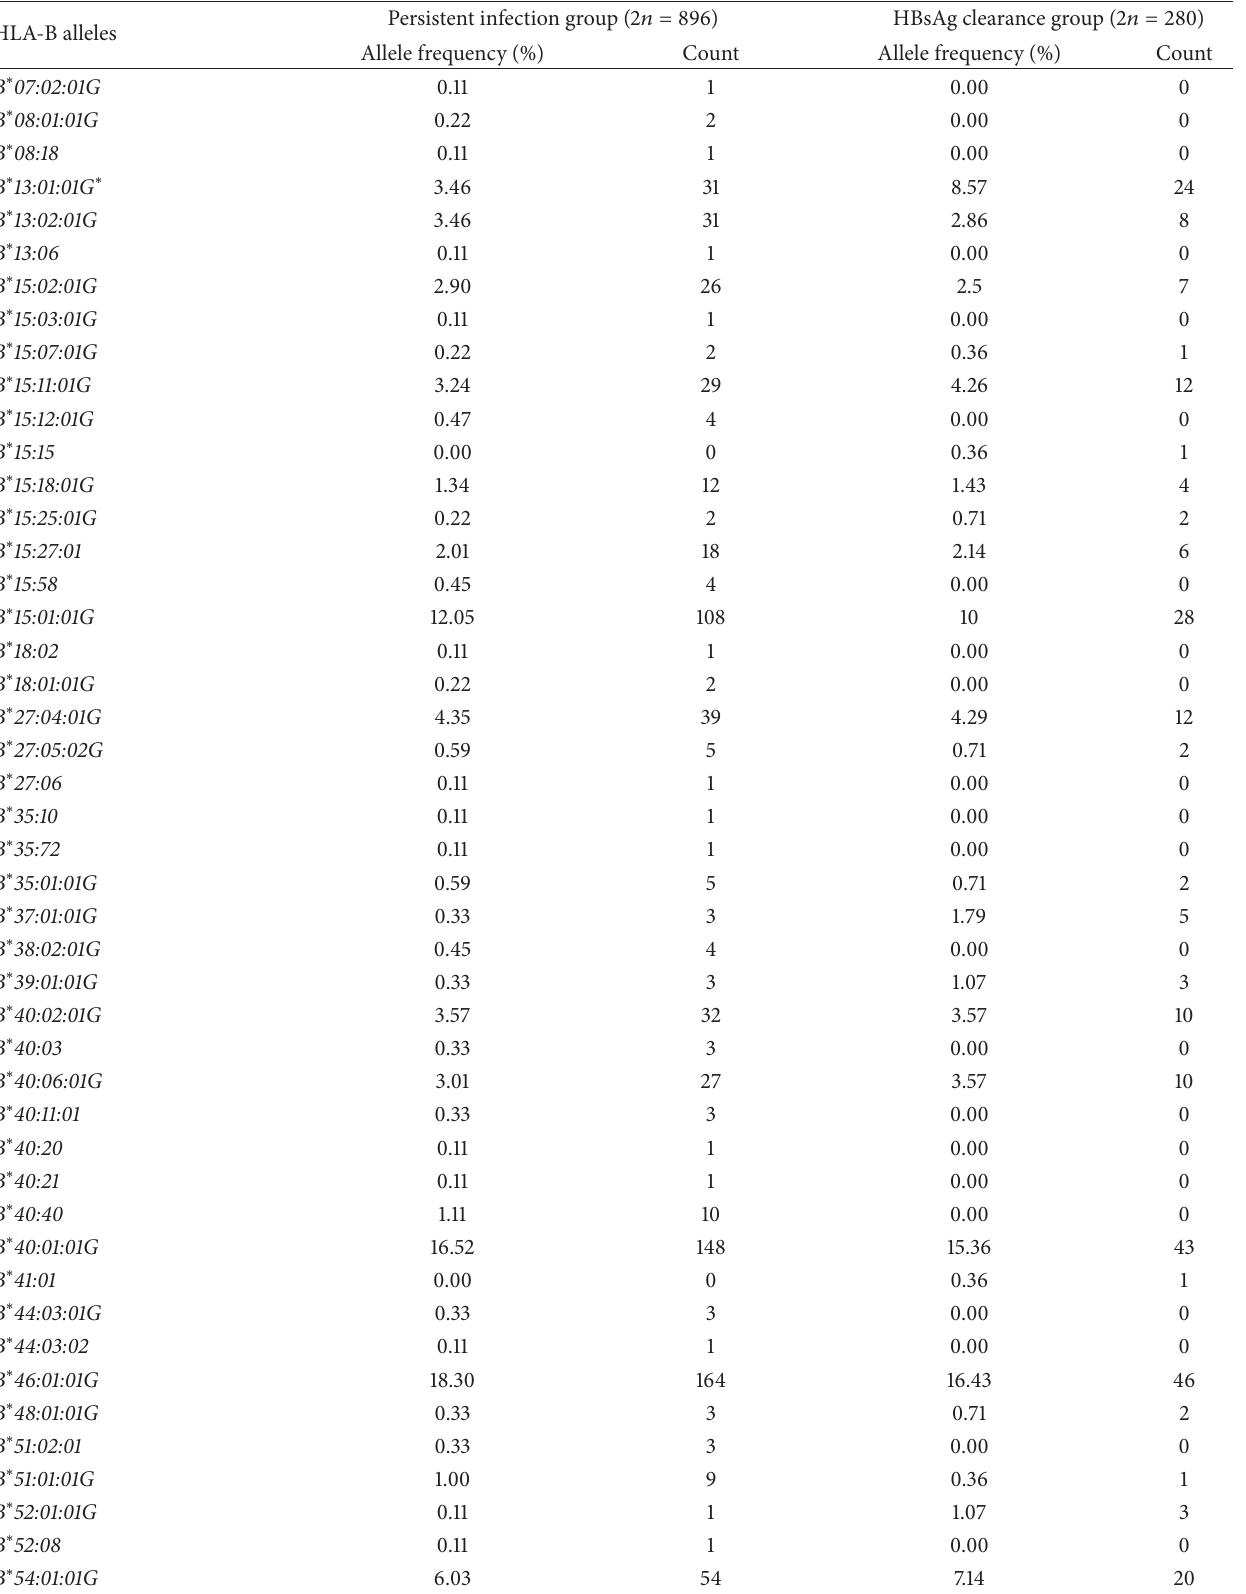
Table 2: Frequencies of HLA-B alleles in each study group. Persistent infection group ( 2𝑛 = 896 ) HBsAg clearance group ( 2𝑛 = 280 HLA-B alleles